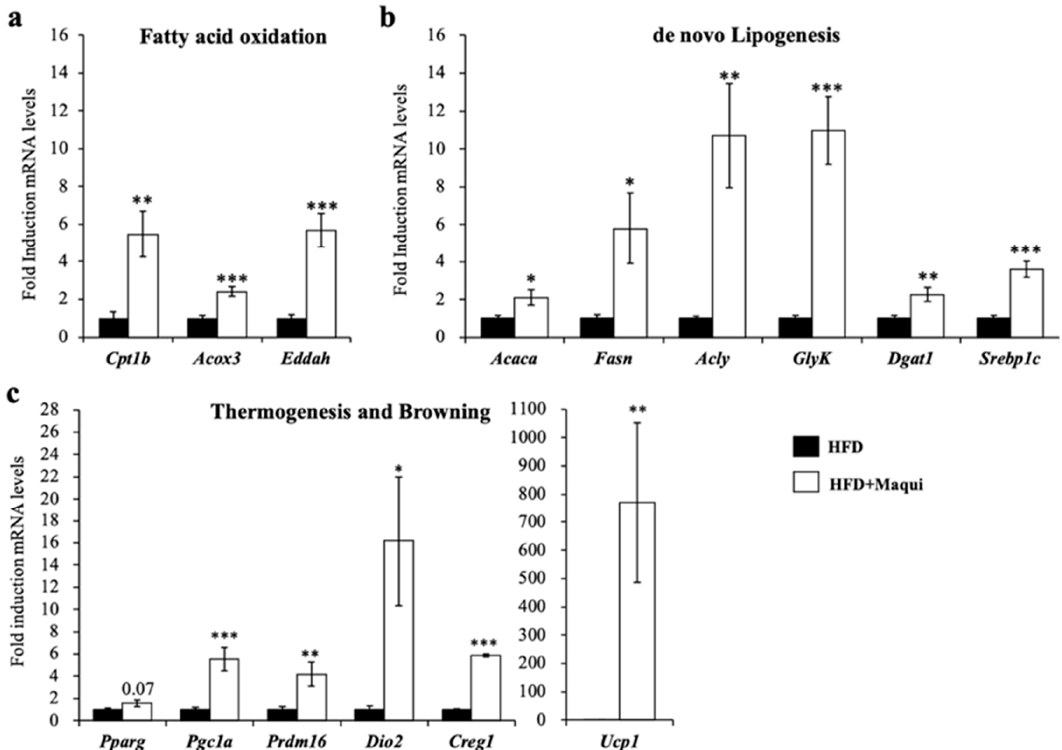
Figure 3. Maqui induces the expression of genes from de novo lipogenesis, fatty acid oxidation, thermogenesis / browninginscWAT.TherelativemRNAlevelsofcharacteristicgenesof( a )mitochondrial and peroxisomal FAO ( Cpt1b, Acox3, and Ehhadh ), ( b ) DNL ( Acaca, Acly, Fasn, GlyK, Dgat1 and Srebp1c ) and ( c ) thermogenesis and browning ( Ucp1, Type 2 Iodothyronine Deiodinase (Dio2), PR-Domain Zinc Finger Protein 16 (Prdm16), Peroxisome proliferator-activated receptor gamma (Pparg), Peroxisome proliferator-activated receptor gamma coactivator 1 alpha (Pgc1a) and Cellular repressor of adenovirus early region 1A–stimulated genes 1 (CREG1) ) were measured using qRT-PCR in scWAT of HFD and HFDM mice. Bars represent the fold induction in the mRNA levels versus the HFD animals that are considered the control group, which produces an arbitrary value of 1. Data are presented as the mean ± SEM. * p < 0.05, ** p < 0.01, *** p < 0.001 versus the HFD